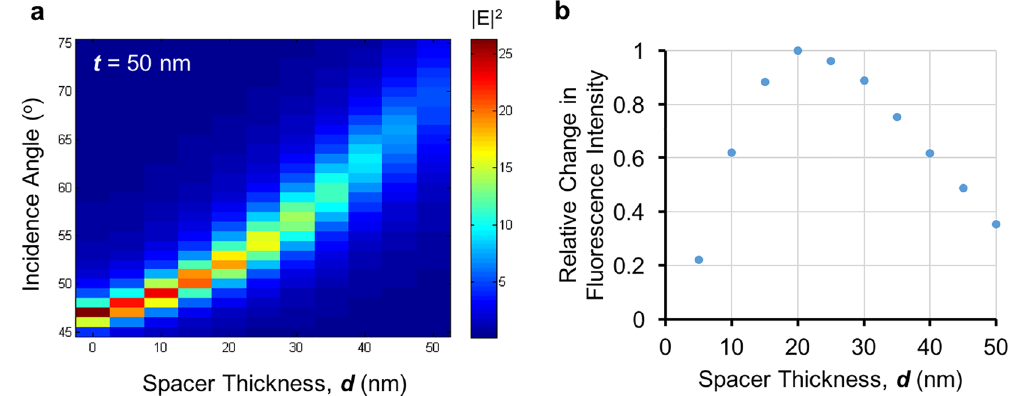
Figure 3. Numerical simulation of surface-enhanced fluorescence in close proximity of a thin silver film. ( a ) Numerical simulation of the electric field intensity at the SiO 2 -air interface, corresponding to 50 nm silver- coated substrates as a function of the incidence angle and the spacer distance under 470 nm illumination. ( b ) Simulated relative change in fluorescence intensity of a fluorophore in the vicinity of a 50 nm thick silver film as a function of the spacer